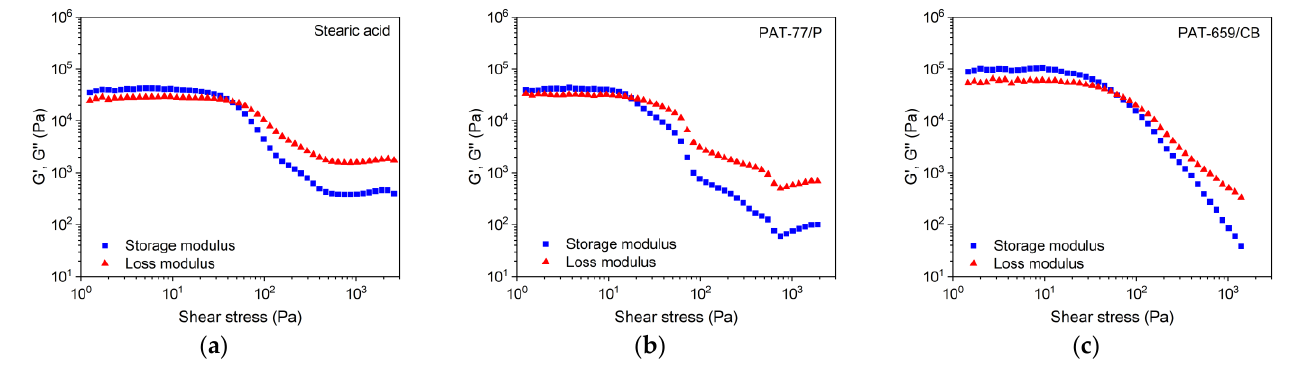
Figure 7. Storage (G’) and loss modulus (G’’) of PEG 8000/PVB systems containing three different surfactants (temperature 160 °C, solid load 60 vol%) via oscillatory test applying amplitude sweep.